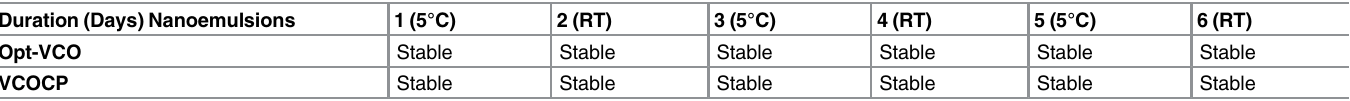
Table 9. Freeze-thaw cycle.